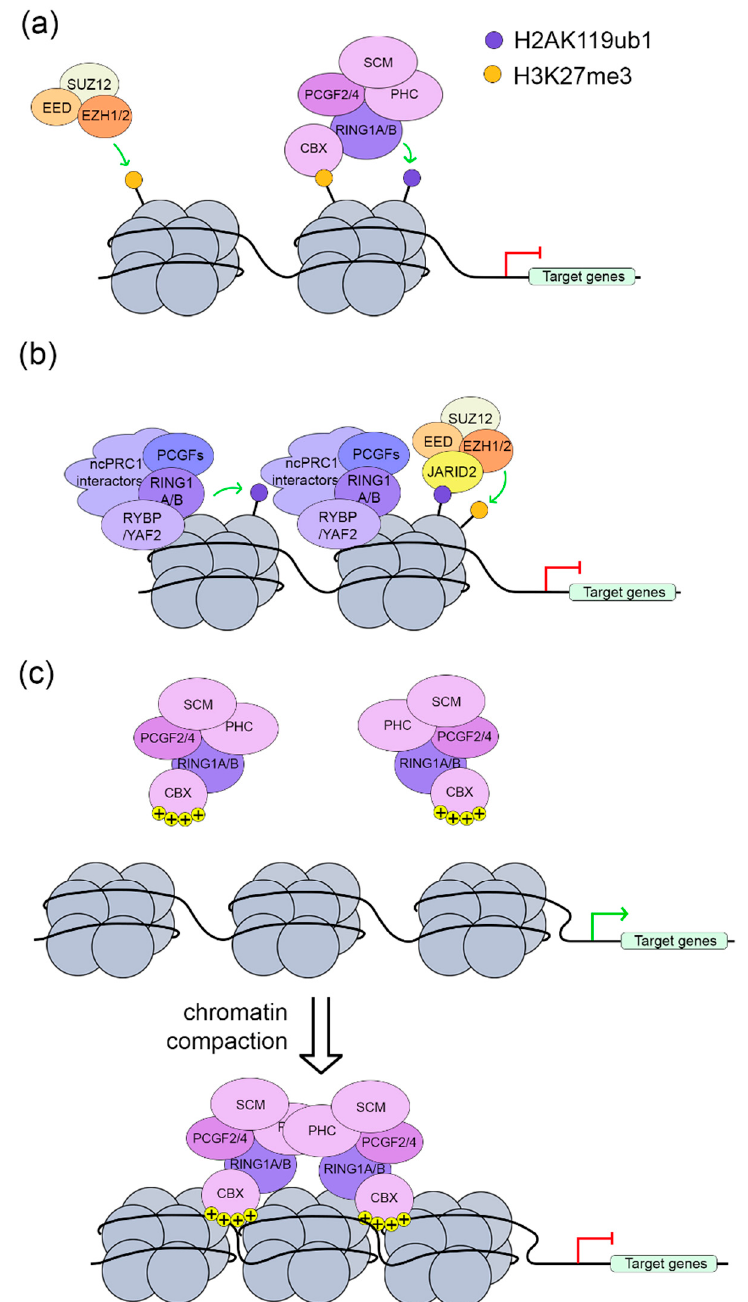
Figure 2. PRC1-mediated transcription repression. ( a ) Crosstalk between cPRC1 and PRC2.